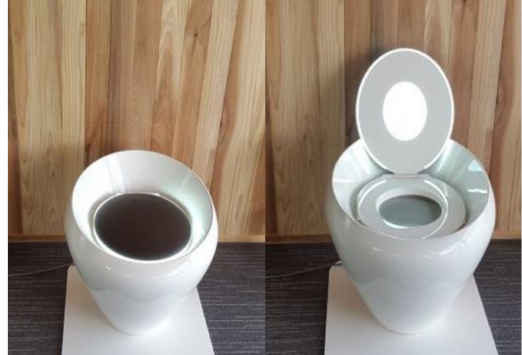
Figure 2. Prototype of the waterless